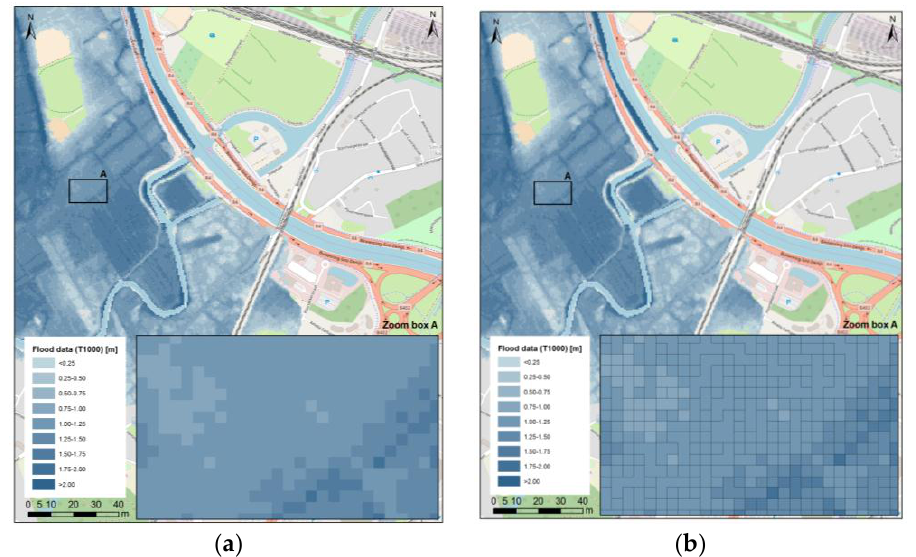
Figure 12. Raster-based flood data ( a ) is converted to polygon-based flood data ( b ) , where each polygon represents an area with no variation in flood characteristics.